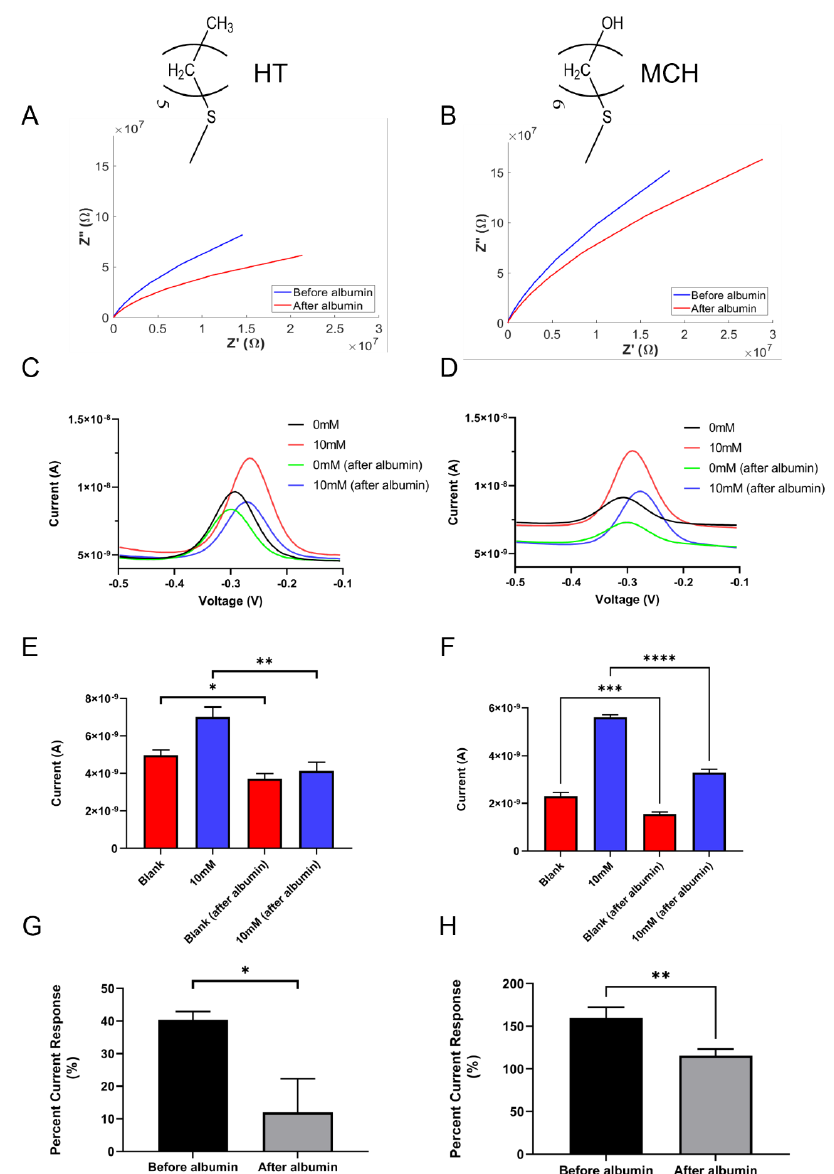
Figure 2. In vitro protein fouling assay for testing effects of different passivation layers. Hydrophobic hexanethiol (HT) is compared with standard hydrophilic 6-mercapto-1-hexanol (MCH). ( A ) Nyquist plot before and after albumin exposure for the HT group. The aptasensor became more resistive after exposed to albumin. ( B ) Nyquist plot before and after albumin exposure for the MCH group. The aptasensor also became more resistive after being exposed to albumin. ( C ) SWV waveform of the HT group before and after albumin exposure. A clear peak amplitude drop can be observed. ( D ) SWV waveform of the MCH group before and after albumin exposure. A background current drop can be observed. ( E ) Quantification of peak current for the HT group. Peak current for both blank PBS and 10 mM cocaine showed significant decrease in amplitude after albumin exposure. One-way ANOVA, n = 5. ( F ) Quantification of peak current for the MCH group. Peak current for both blank PBS and 10 mM cocaine also showed a significant decrease in amplitude after albumin exposure. One-way ANOVA, n = 19. ( G ) Percent current response to 10 mM cocaine for the HT group after albumin exposure. Sensors showed significantly decreased signal towards cocaine after protein exposure. Welch t test, n = 5. ( H ) Percent current response to 10 mM cocaine for the MCH group after albumin exposure. Sensors also showed significantly decreased signal towards cocaine after protein exposure. Welch t test, n = 19. * p < 0.05, ** p < 0.01, *** p < 0.0005, **** p < 0.0001. All data are represented by mean + SEM. ( A – D ) SEM removed for